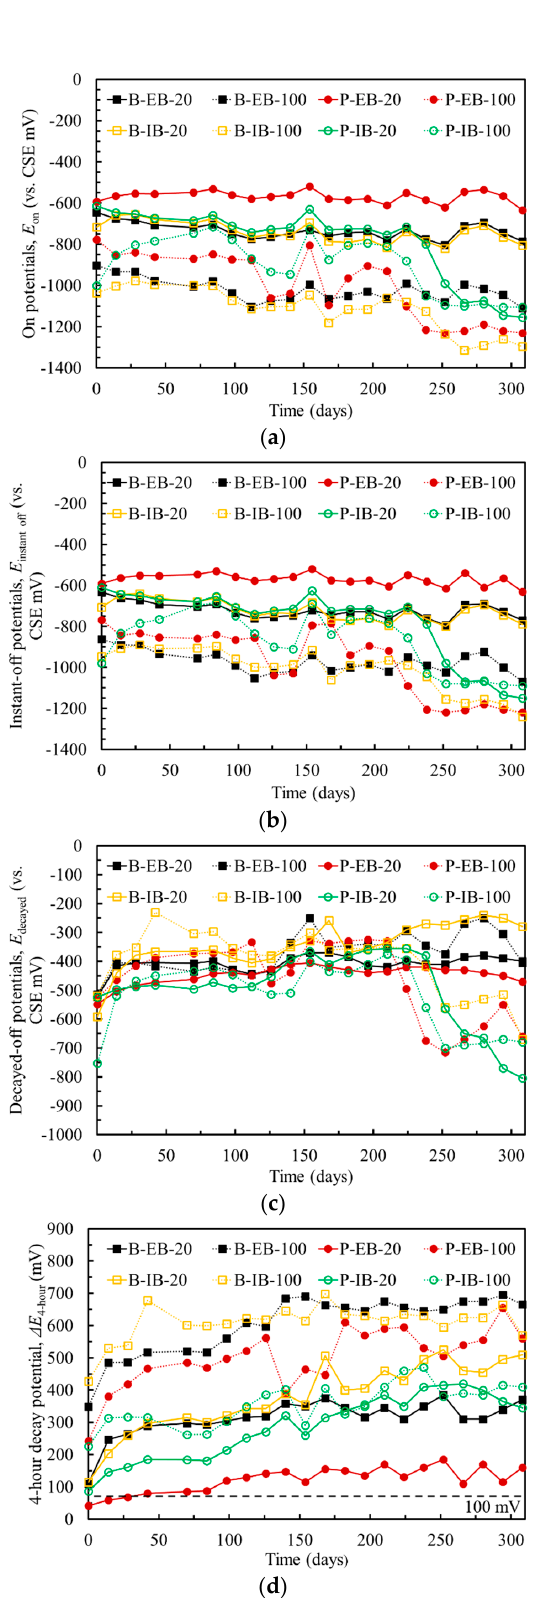
Figure 6. Potentials of the steel rebars and steel plate in the chloride-contaminated concrete before and during EC tests: ( a ) On potentials; ( b ) Instant-off potentials; ( c ) Decayed-off potentials; ( d ) 4-h decay potentials.